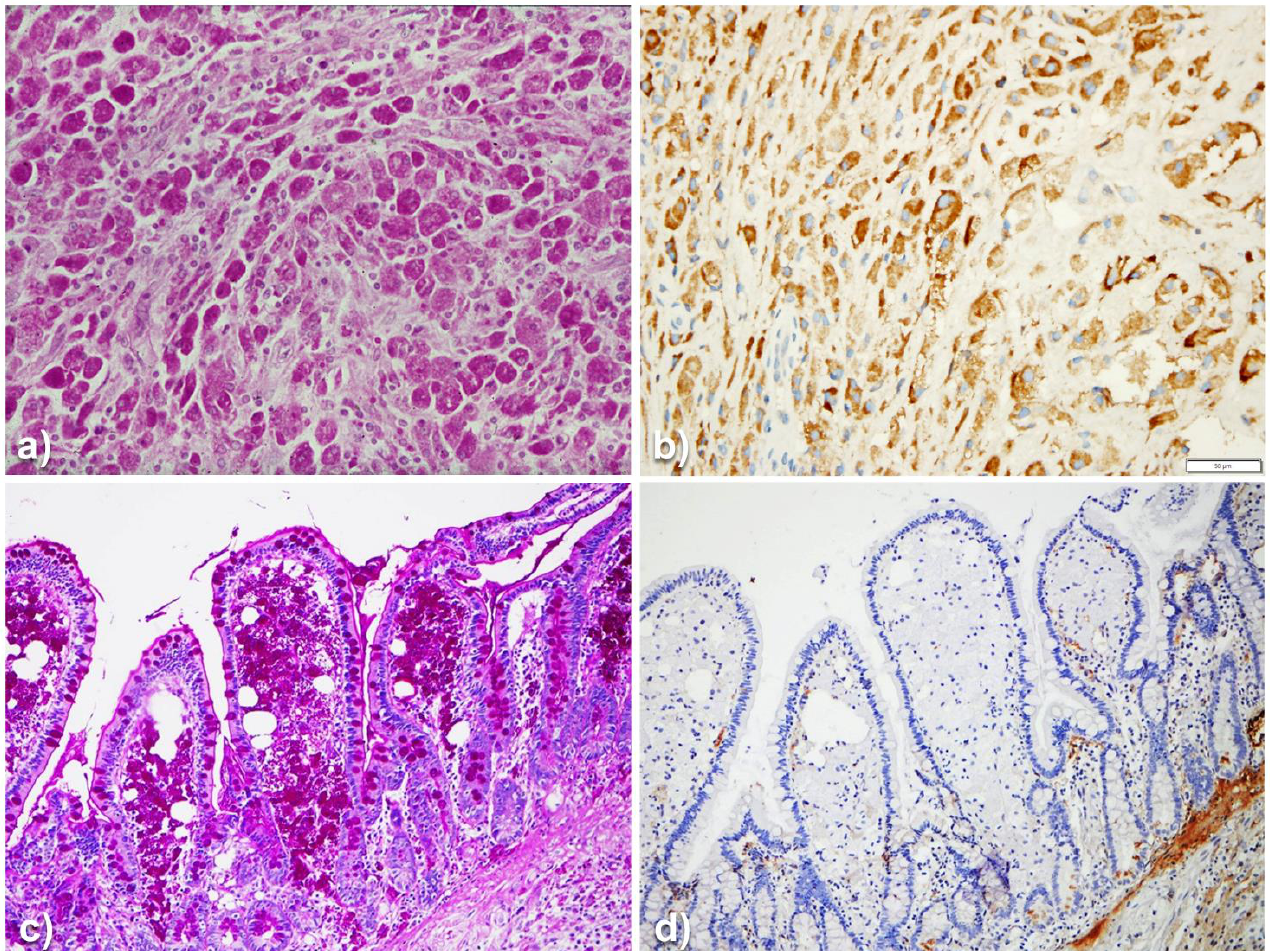
Figure 10. Bladder malakoplakia ( a , b ). Plagues of PAS–D positive macrophages ( a : PAS–D × 40) are strongly positive for AAT ( b : AAT immunostaining × 20). Whipple disease ( c , d ). Intestinal villi contain PAS–D positive macrophages ( c : PAS–D × 40). Goblet epithelial cells and glycocalyx are also positive on PAS–D. Whipple macrophages are negative on AAT immunostaining ( d : AAT immunostaining × 60).